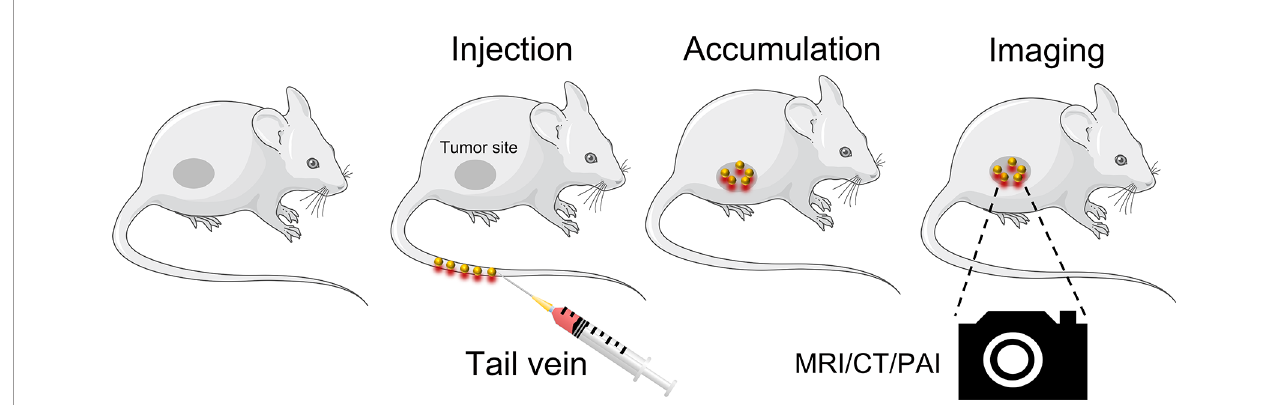
FIGURE 3 | The applications of GNPs in cancer diagnosis.